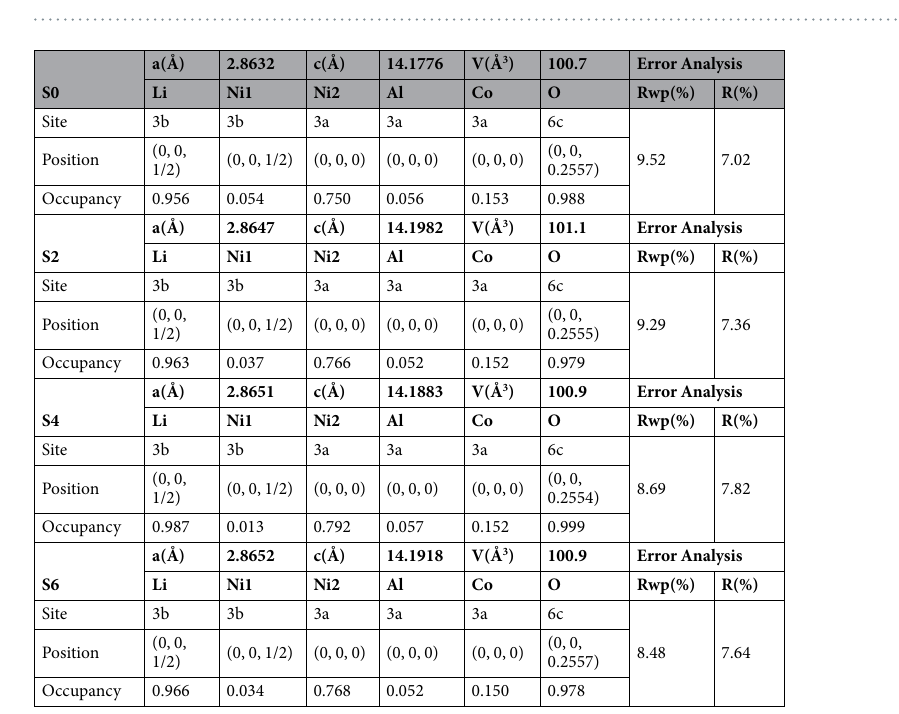
Figure 2. Rietveld refinement of samples: ( a ) S0, ( b ) S2, ( c ) S4 and ( d ) S6.